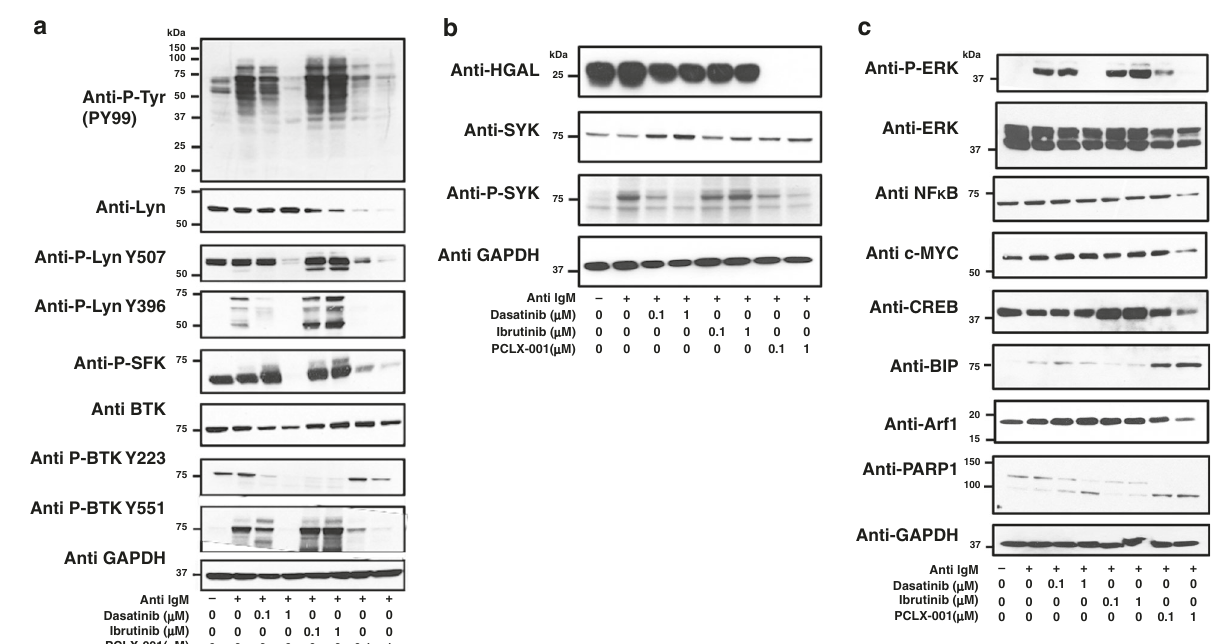
Fig. 4 PCLX-001 treatment attenuates BCR downstream signaling events in BL2 lymphoma cells. Western blot of BL2 cells treated for 48 h with 0.1 µ M or 1.0 μ M of dasatinib, ibrutinib or PCLX-001 to detect total tyrosine phosphorylation (P-Tyr), Lyn, Lyn phosphorylated on tyrosine 396 or 507, BTK, and BTK phosphorylated on tyrosines 223 or 551 ( a ), HGAL, SYK, phosphorylated SYK (P-SYK) ( b ) or ERK, phosphorylated ERK (P-ERK), NF κ B, c-Myc, CREB, Arf-1, BIP, and PARP-1 ( c ). Western blots are representative of at least three independent experiments. GAPDH serves as a loading control. BL2 cells were activated with 25 μ g/ml F(ab ’ ) 2 anti-human IgM for 2 min and processed for western blotting. All western blots shown are representative of three independent experiments. Source data are provided as a Source Data fi